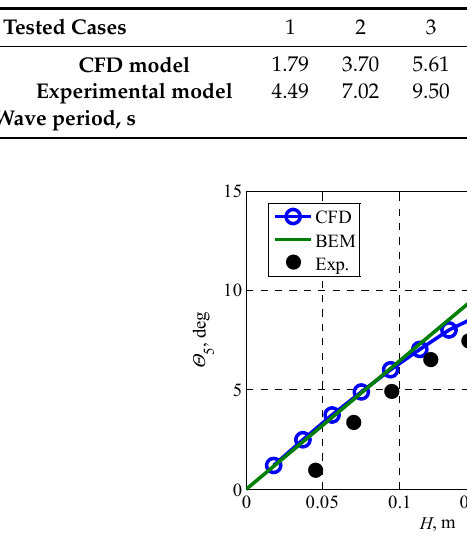
Figure 8. Comparison of pitch angular displacement amplitude as a function of wave height among CFD, BEM and experimental results at T = 1.6